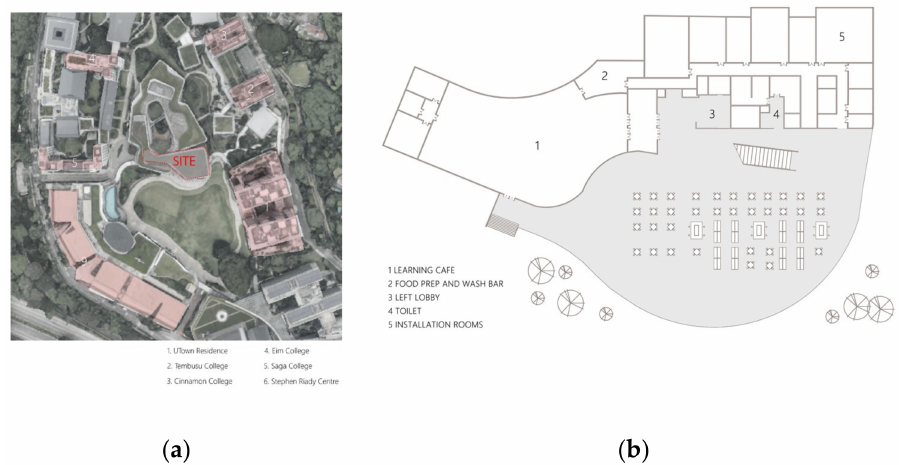
Figure 3. The location of the area: ( a ) the ERC general plan and ( b ) ERC ground floor plan.